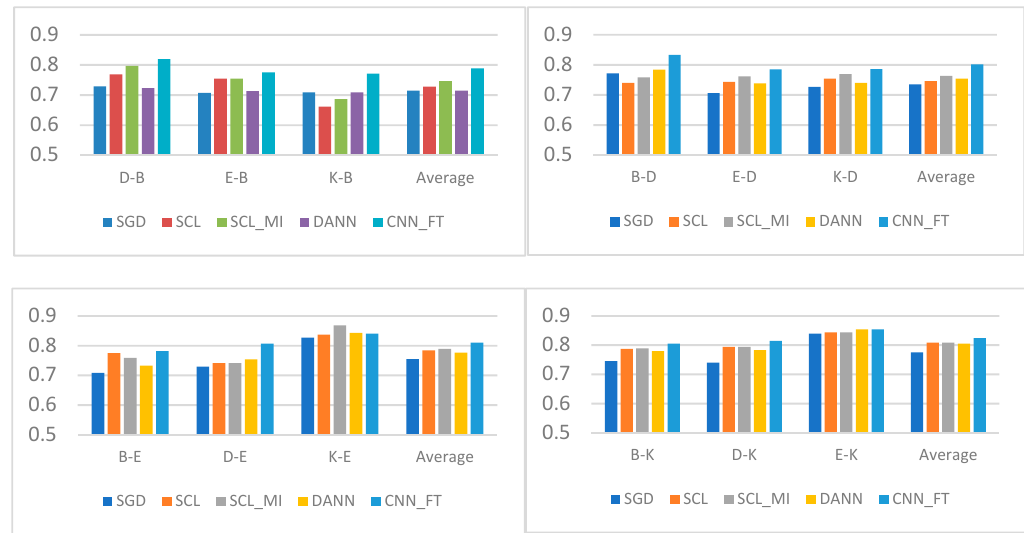
Figure 5. CNN_FT vs. other methods.